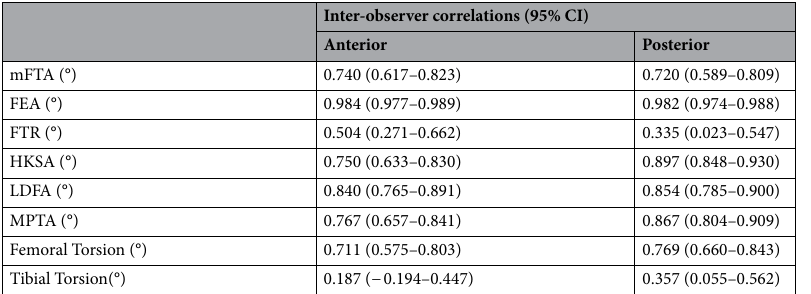
Table 2. Inter-observer correlation (95% CI) of the alignment parameters on the EOS 3D system according to the posture of indexed lower extremity. 3D three-dimensional, CI confidence interval, mTFA mechanical femorotibial angle, FEA flexion–extension angle, FTR femorotibial rotation, HKSA hip-knee-shaft angle, LDFA lateral distal femoral angle, MPTA medial proximal tibial angle.